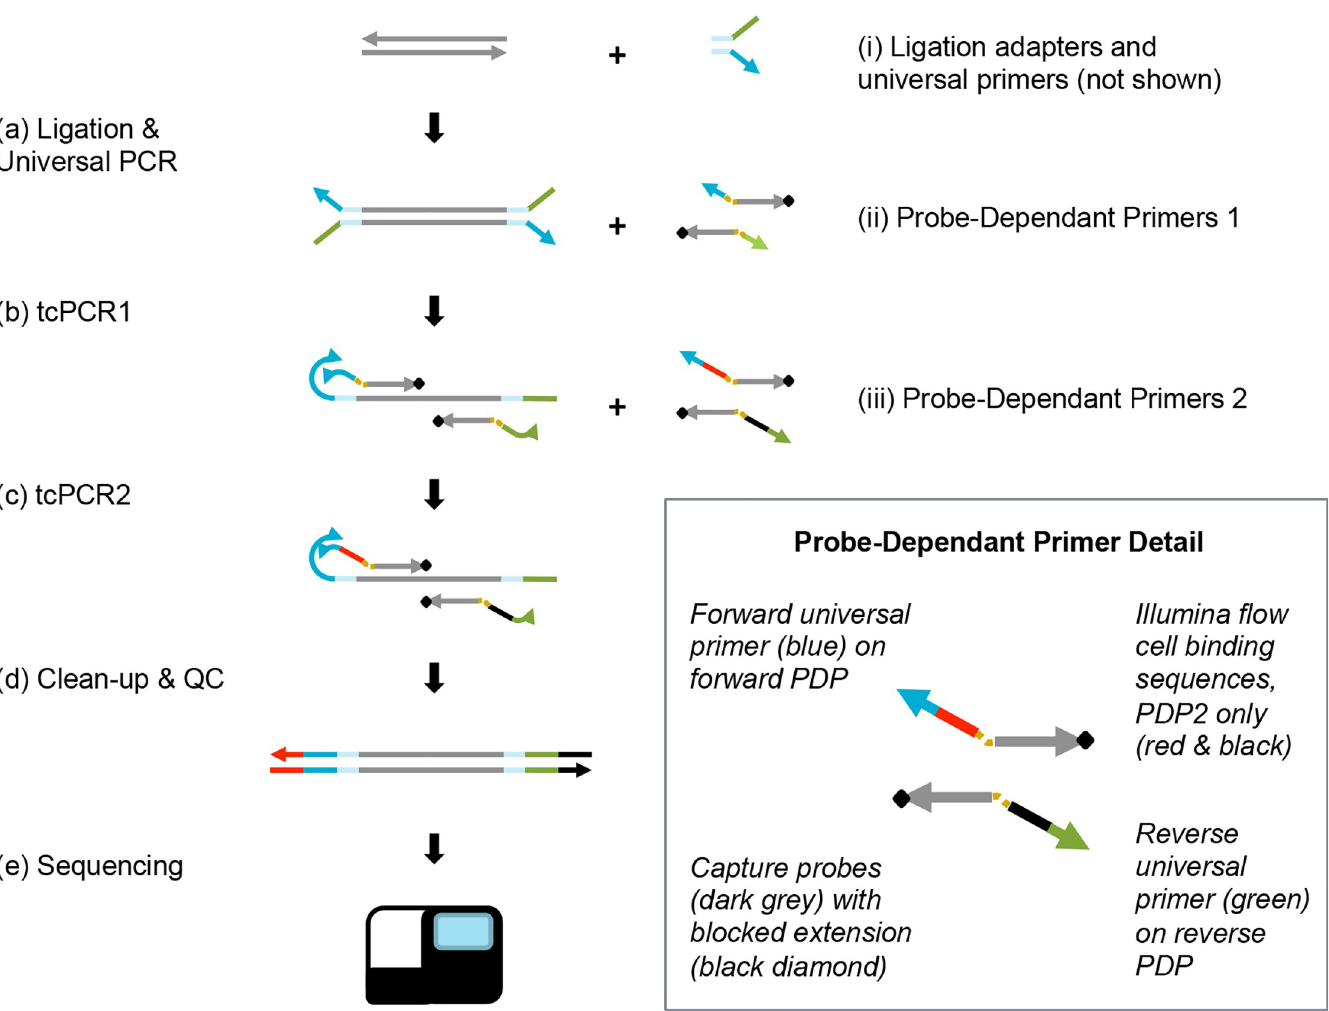
Fig 1. Linked target capture workflow. (a) Custom adapters (i) are ligated to template DNA and the resulting product is amplified with universal primers. (b) Target regions are selectively amplified using custom probe-dependent primers (PDPs) (ii) which contain a recognition sequence (dark grey) with a 3’ blocker (black diamond) and are linked to an oligo containing a universal priming sequence for the first target capture PCR reaction (tcPCR1). (c) A second set of PDPs (iii), which contain Illumina adapters (red and black) between the probe and linked universal primer, are then added and a second target capture PCR reaction (tcPCR2) is completed prior to (d), clean up and QC and (e) loading on a sequencer. The inset shows detail of forward and reverse